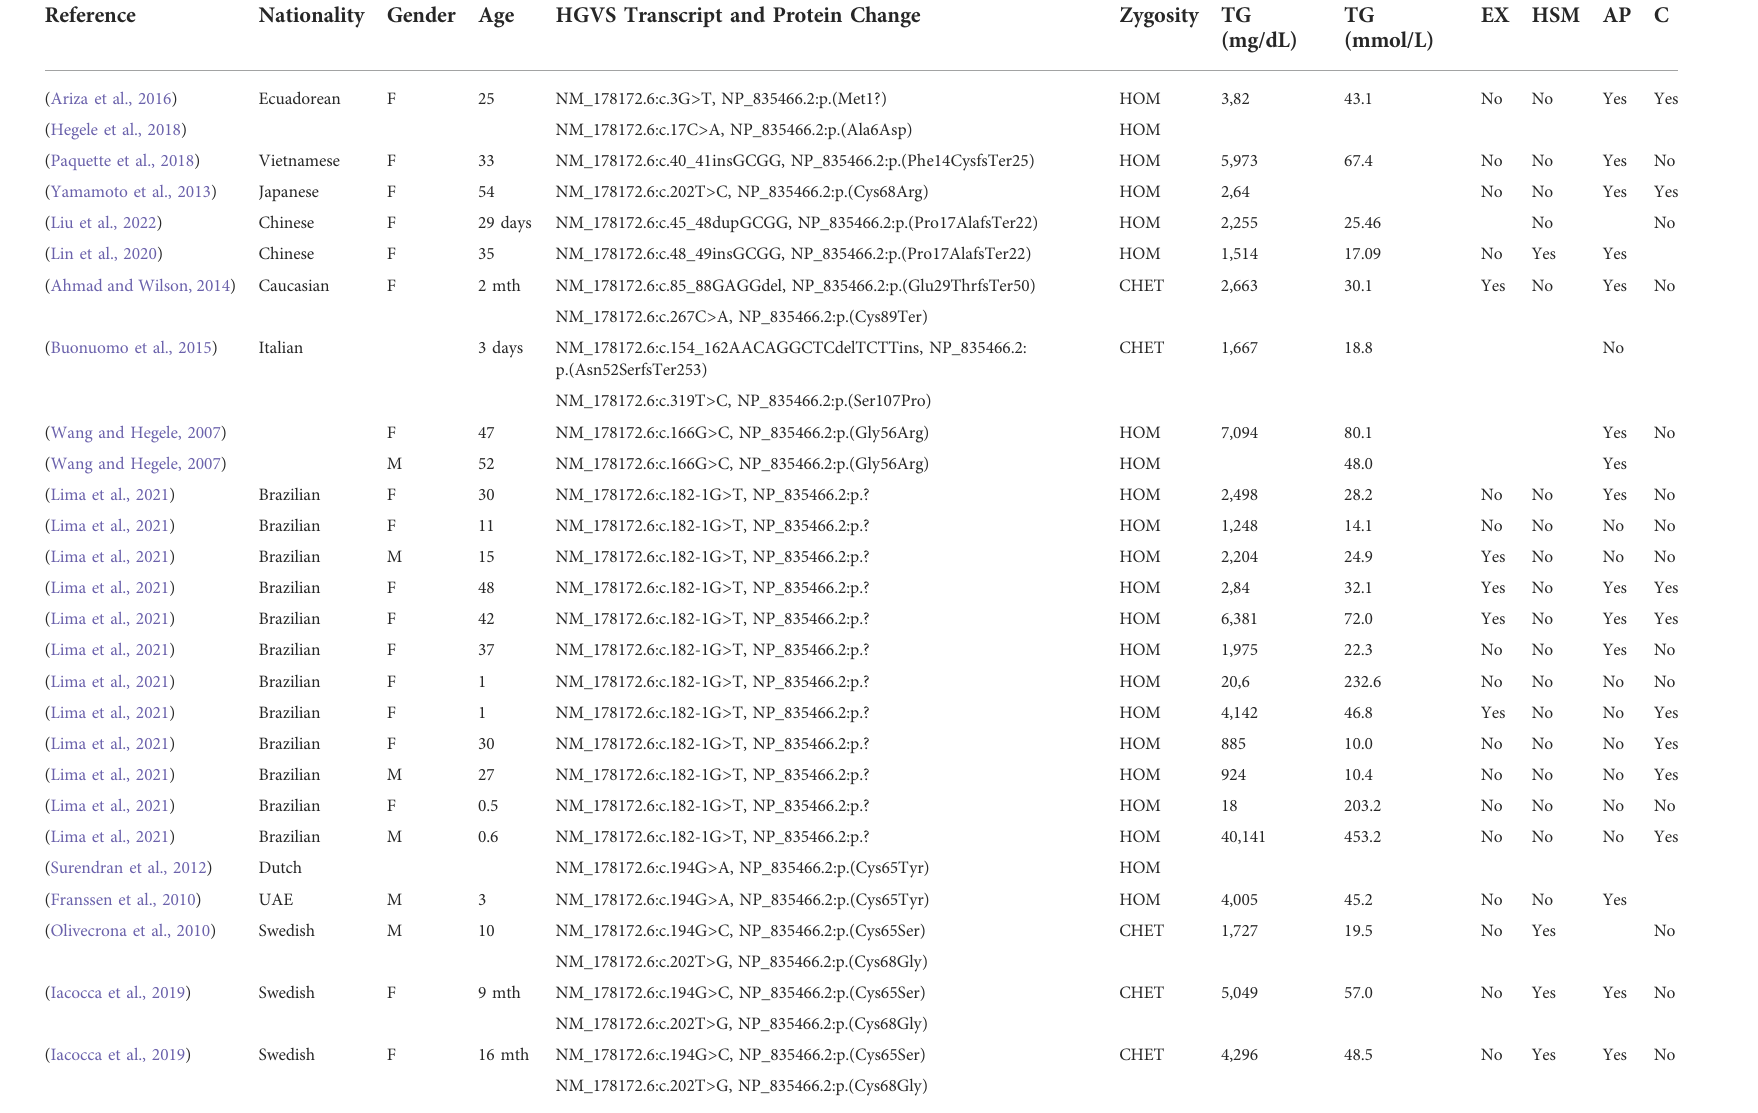
TABLE 1 Review of pathogenic variants in GPIHBP1 gene from the